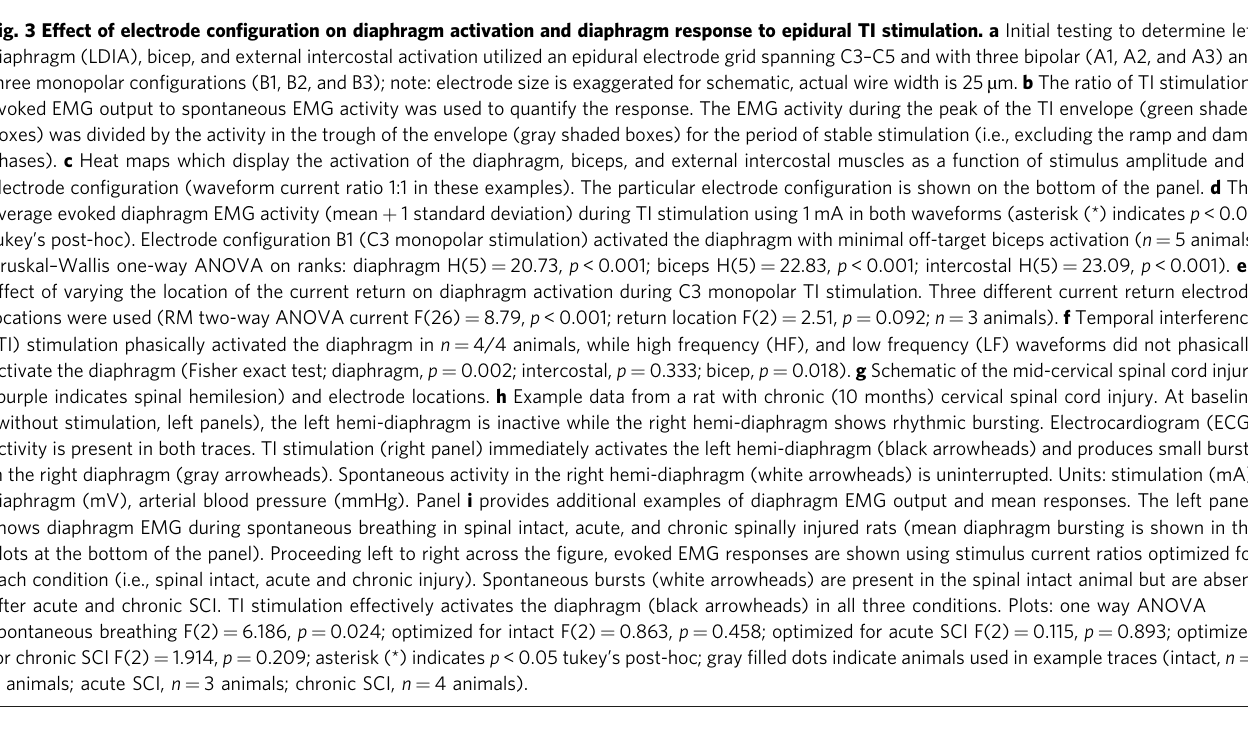
Fig. 3 Effect of electrode con fi guration on diaphragm activation and diaphragm response to epidural TI stimulation. a Initial testing to determine left diaphragm (LDIA), bicep, and external intercostal activation utilized an epidural electrode grid spanning C3 – C5 and with three bipolar (A1, A2, and A3) and three monopolar con fi gurations (B1, B2, and B3); note: electrode size is exaggerated for schematic, actual wire width is 25 µ m. b The ratio of TI stimulation- evoked EMG output to spontaneous EMG activity was used to quantify the response. The EMG activity during the peak of the TI envelope (green shaded boxes) was divided by the activity in the trough of the envelope (gray shaded boxes) for the period of stable stimulation (i.e., excluding the ramp and damp phases). c Heat maps which display the activation of the diaphragm, biceps, and external intercostal muscles as a function of stimulus amplitude and electrode con fi guration (waveform current ratio 1:1 in these examples). The particular electrode con fi guration is shown on the bottom of the panel. d The average evoked diaphragm EMG activity (mean + 1 standard deviation) during TI stimulation using 1 mA in both waveforms (asterisk (*) indicates p < 0.05 tukey ’ s post-hoc). Electrode con fi guration B1 (C3 monopolar stimulation) activated the diaphragm with minimal off-target biceps activation ( n = 5 animals, Kruskal – Wallis one-way ANOVA on ranks: diaphragm H(5) = 20.73, p < 0.001; biceps H(5) = 22.83, p < 0.001; intercostal H(5) = 23.09, p < 0.001). e Effect of varying the location of the current return on diaphragm activation during C3 monopolar TI stimulation. Three different current return electrode locations were used (RM two-way ANOVA current F(26) = 8.79, p < 0.001; return location F(2) = 2.51, p = 0.092; n = 3 animals). f Temporal interference (TI) stimulation phasically activated the diaphragm in n = 4/4 animals, while high frequency (HF), and low frequency (LF) waveforms did not phasically activate the diaphragm (Fisher exact test; diaphragm, p = 0.002; intercostal, p = 0.333; bicep, p = 0.018). g Schematic of the mid-cervical spinal cord injury (purple indicates spinal hemilesion) and electrode locations. h Example data from a rat with chronic (10 months) cervical spinal cord injury. At baseline (without stimulation, left panels), the left hemi-diaphragm is inactive while the right hemi-diaphragm shows rhythmic bursting. Electrocardiogram (ECG) activity is present in both traces. TI stimulation (right panel) immediately activates the left hemi-diaphragm (black arrowheads) and produces small bursts in the right diaphragm (gray arrowheads). Spontaneous activity in the right hemi-diaphragm (white arrowheads) is uninterrupted. Units: stimulation (mA), diaphragm (mV), arterial blood pressure (mmHg). Panel i provides additional examples of diaphragm EMG output and mean responses. The left panel shows diaphragm EMG during spontaneous breathing in spinal intact, acute, and chronic spinally injured rats (mean diaphragm bursting is shown in the plots at the bottom of the panel). Proceeding left to right across the fi gure, evoked EMG responses are shown using stimulus current ratios optimized for each condition (i.e., spinal intact, acute and chronic injury). Spontaneous bursts (white arrowheads) are present in the spinal intact animal but are absent after acute and chronic SCI. TI stimulation effectively activates the diaphragm (black arrowheads) in all three conditions. Plots: one way ANOVA spontaneous breathing F(2) = 6.186, p = 0.024; optimized for intact F(2) = 0.863, p = 0.458; optimized for acute SCI F(2) = 0.115, p = 0.893; optimized for chronic SCI F(2) = 1.914, p = 0.209; asterisk (*) indicates p < 0.05 tukey ’ s post-hoc; gray fi lled dots indicate animals used in example traces (intact, n